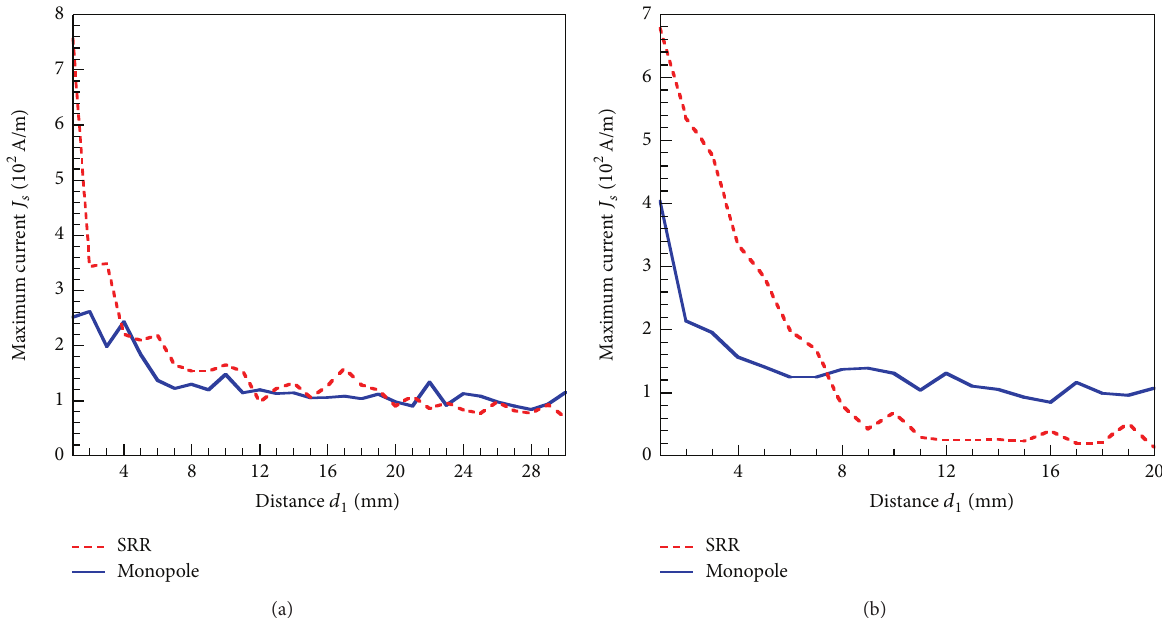
Figure 8: Maximum current 𝐽 𝑆 (A/m), at the operating frequency 𝐹 𝑅 , on the monopole, and the SRR versus the coupling distance 𝑑 1 : (a) configuration A1 ( 𝐹 𝑅 = 1.55 GHz), (b) configuration A2 ( 𝐹 𝑅 = 1.75 GHz).